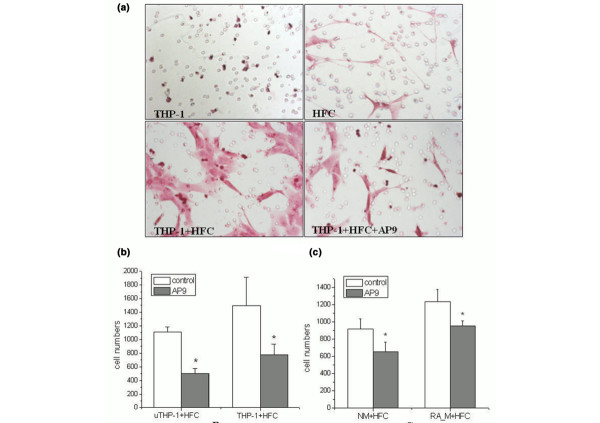
Effect of CD147 antagonistic peptide 9 (AP9) on the invasive ability of the co-culture cells. (a) The haematoxylin and eosin staining results of the lower surface filters show that the cells had invaded through the filter and attached to the lower side of the filter (× 150). In the co-culture of undifferentiated THP-1 cells and HFC, the number of cells was increased compared with the cultures of THP-1 cells or HFC alone. (b) Effect of AP9 on the number of cells that invaded through the Matrigel coated filter in the co-culture of undifferentiated or differentiated THP-1 cells and HFC. The number of cells that invaded through the filter was counted, showing that when AP9 was added the number of cells decreased. Asterisks indicate a p-value <0.01. (c) Effect of AP9 on the number of cells that invaded through the Matrigel coated filter in a co-culture of human CD14+ monocytes and HFC. The number of cells decreased when AP9 was added. Asterisks indicate a p-value < 0.05. HFC, Human fibroblast cells.